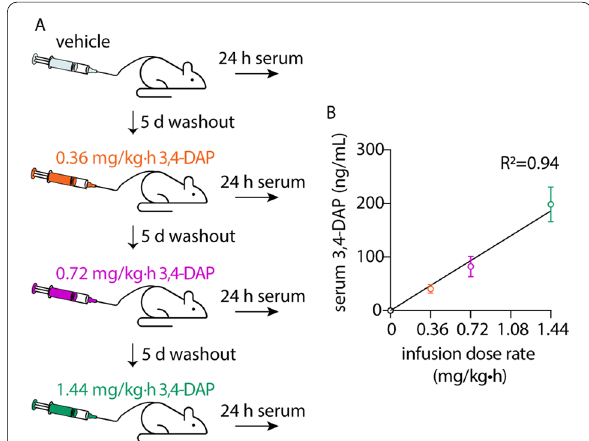
Fig. 2 Correlation of infusion dose and 3,4‑DAP C SS after 24 h. Catheterized rats (n 7) were subcutaneously infused for 24 h = with 3,4‑DAP at 0 (saline vehicle), 0.36, 0.72 and 1.44 mg/kg h, with a 5‑day washout between doses. Serum was collected after 24 h and analyzed for 3,4‑DAP. A Summary of experimental strategy. B Mean SD values for serum 3,4‑DAP concentrations after 24 h ± infusion at each infusion dose rate. Linear regression demonstrated a strong fit between serum 3,4‑DAP levels and infusion dose rate (R 2 =